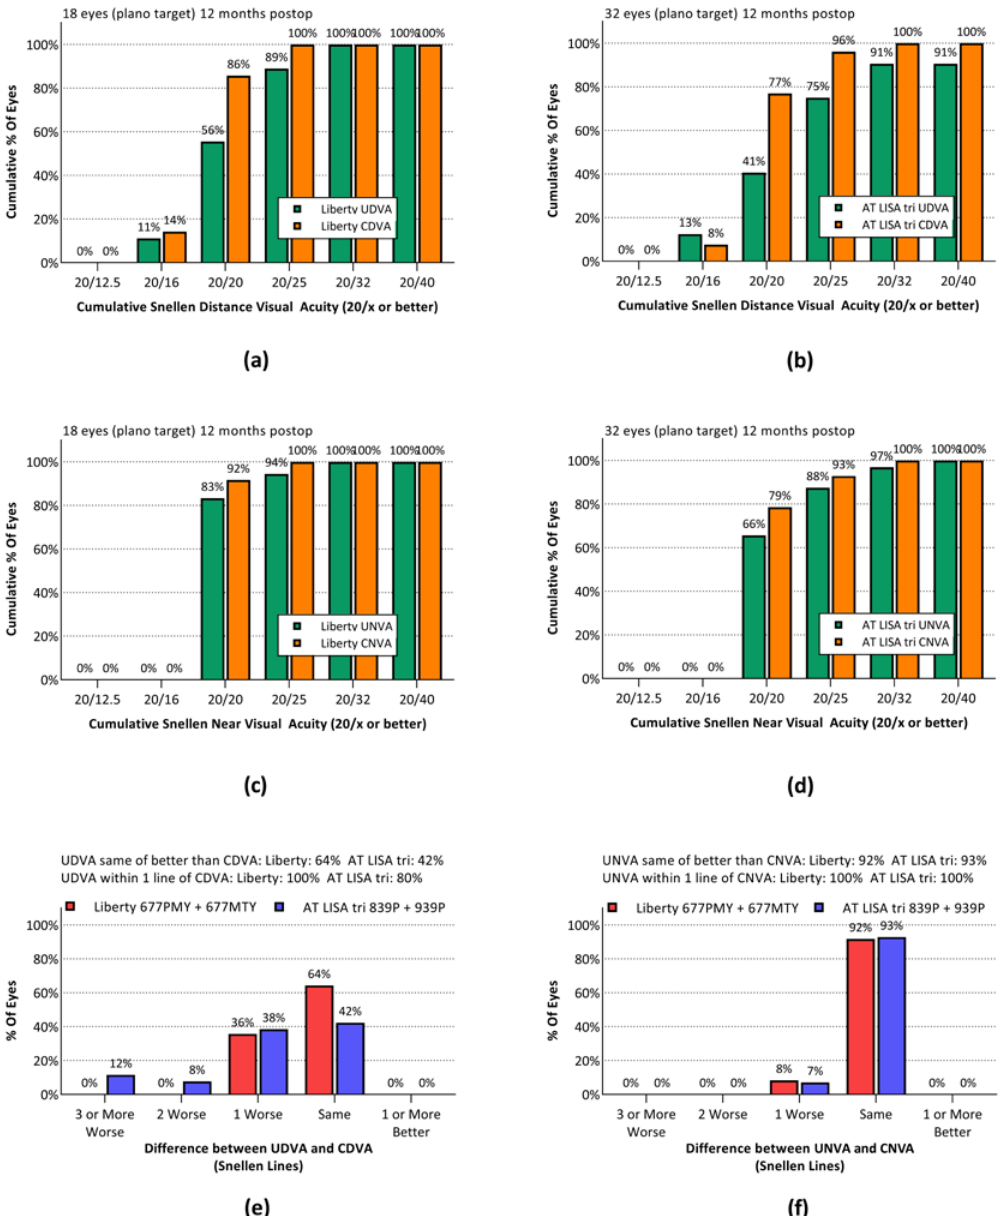
Figure 2. Cumulative Snellen uncorrected and corrected visual acuities for distance and near vision, measured 12 months after surgery. ( a ) Cumulative distance visual acuities for the Liberty group. ( b ) Cumulative distance visual acuities for the AT LISA tri group. ( c ) Cumulative near visual acuities for the Liberty group. ( d ) Cumulative near visual acuities for the AT LISA tri group. ( e ) Difference between UDVA and CDVA in Snellen lines for the Liberty group. ( f ) Difference between UDVA and CDVA in Snellen lines for the AT LISA tri group. UDVA: uncorrected distance visual acuity. CDVA: corrected distance visual acuity. UNVA: uncorrected near visual acuity. CNVA: corrected near visual acuity.